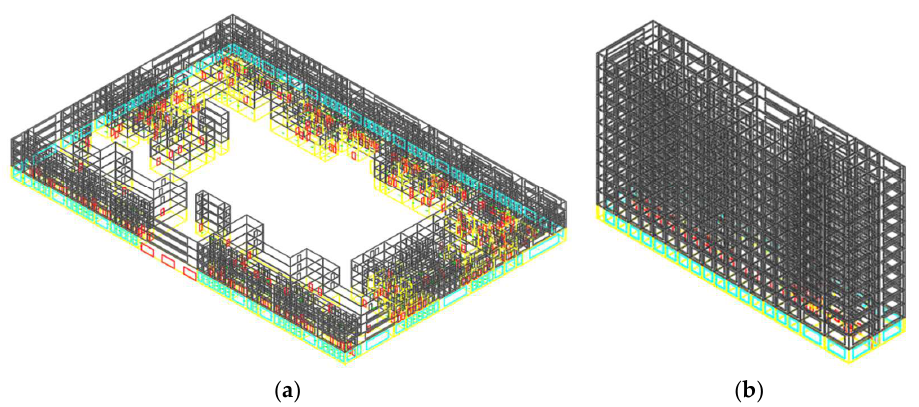
Figure 13. Building model of outpatient building ( a ) and inpatient building ( b ).